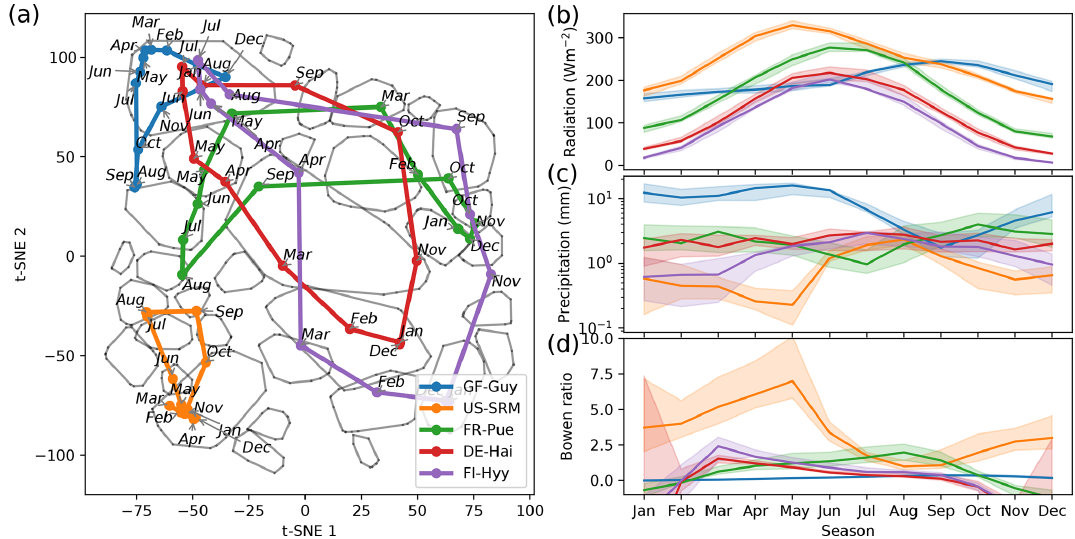
Figure 5. Median trajectories of selected sites (a) and their corresponding mean values of radiation, precipitation, and the Bowen ratio (b) . In winter months the Bowen ratio can turn negative. Nevertheless we set the lower limit of the y axis to 0. As networks are calculated using a centred 3-month moving window, each month is ascribed to a network. Thus, the behaviour of an ecosystem can be tracked by its monthly networks, which form trajectories for each year. An ecosystem’s monthly median trajectory is composed of the two-dimensional monthly median networks (see Sect. 2.7 for